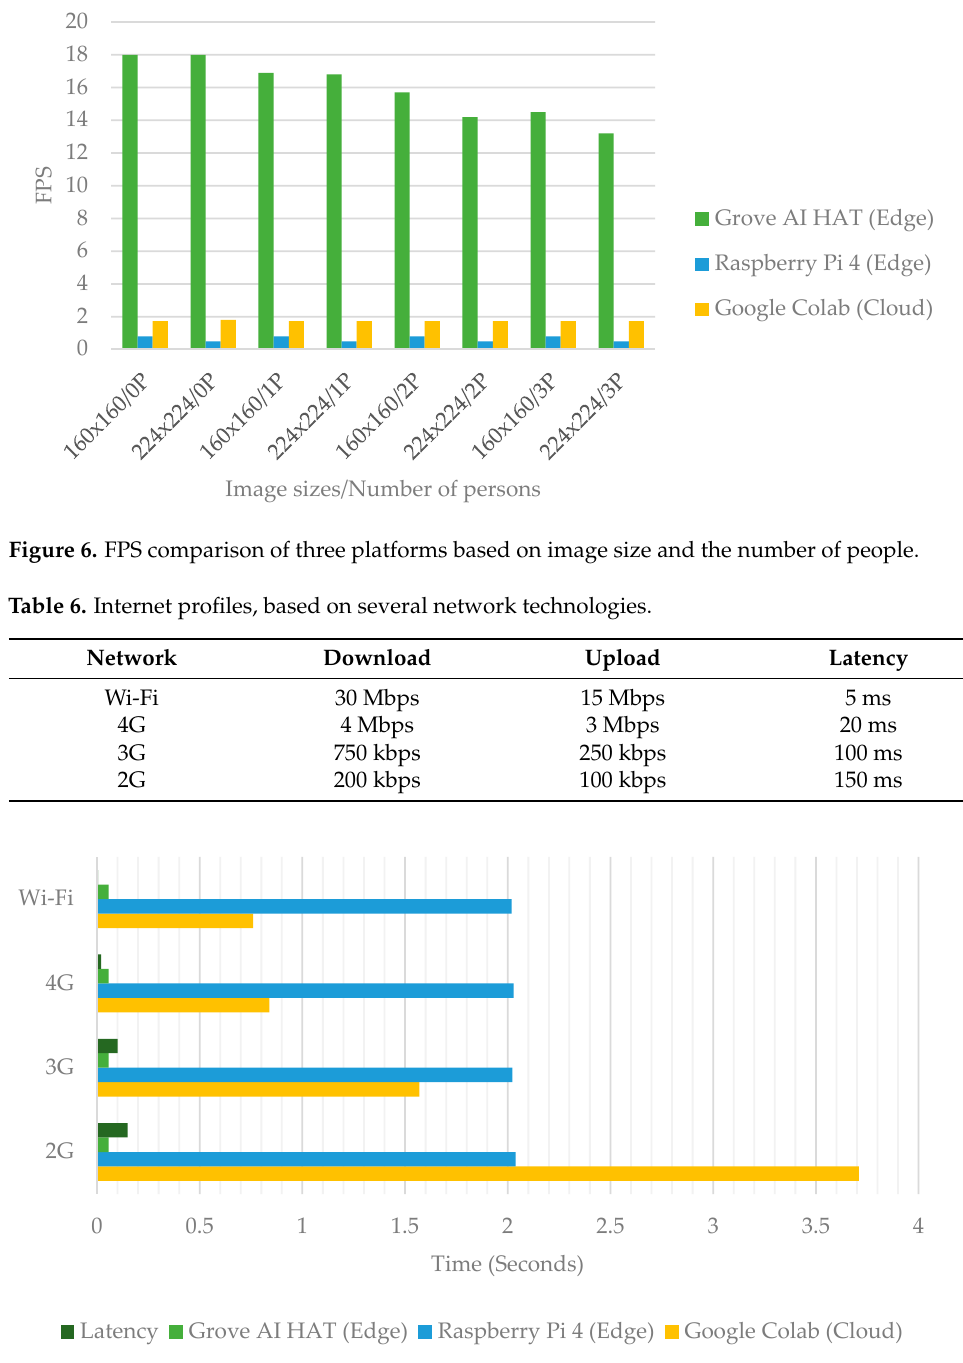
Figure 7. Experimental program execution time in different networks.